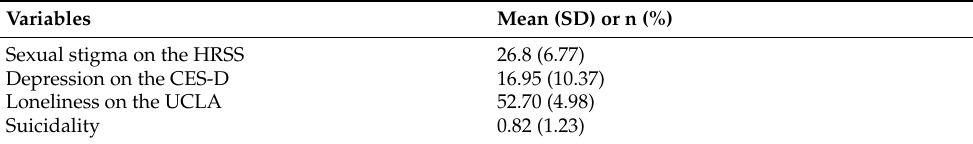
Table 2. Participants’ perceived sexual stigma outside military service, depression, loneliness, and suicidality (N =